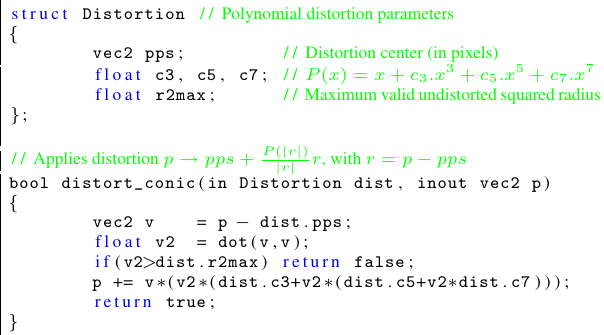
struct Distortion // Polynomial distortion parameters {